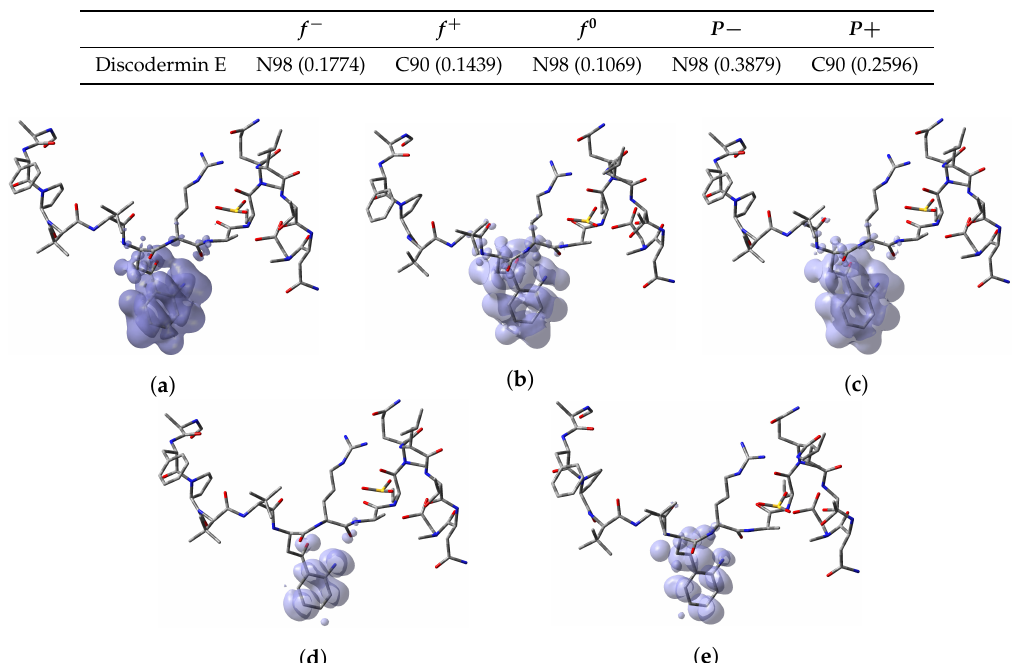
Figure A4. Graphical sketches of the local reactivity descriptors for Discodermin D showing the reactivity regions: ( a ) Electrophilic Fukui Function f − , ( b ) Nucleophilic Fukui Function f + , ( c ) Radical Fukui Function f 0 , ( d ) Electrophilic Parr Function P − and ( e ) Nucleophilic Parr Function P + . Table A5. Condensed local reactivity descriptors for Discodermin E denoting the reactivity sites: Electrophilic Fukui Function f − , Nucleophilic Fukui Function f + , Radical Fukui Function f 0 , Electrophilic Parr Function P − and Nucleophilic Parr Function P + .